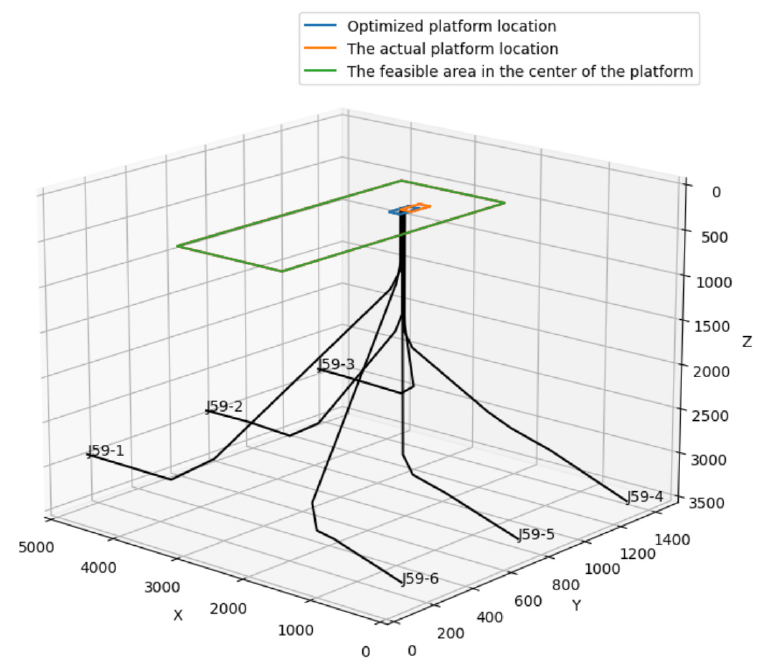
Figure 4. J59 well group drilling platform optimization.